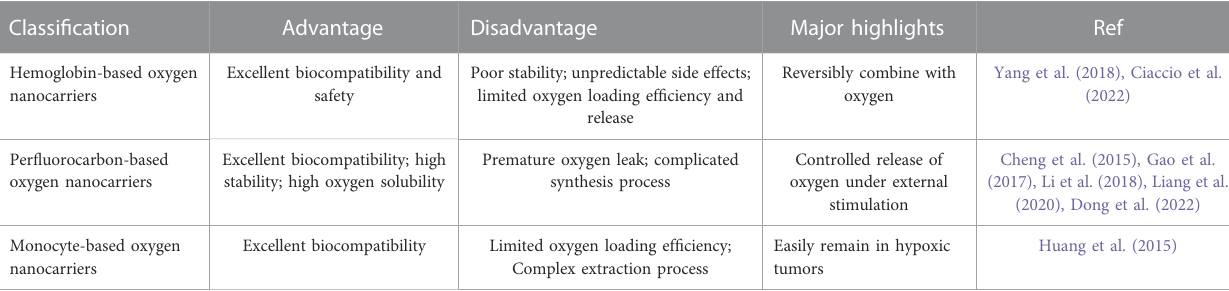
TABLE 2 Oxygen-carrying nanocarriers with advantages, disadvantages, and major